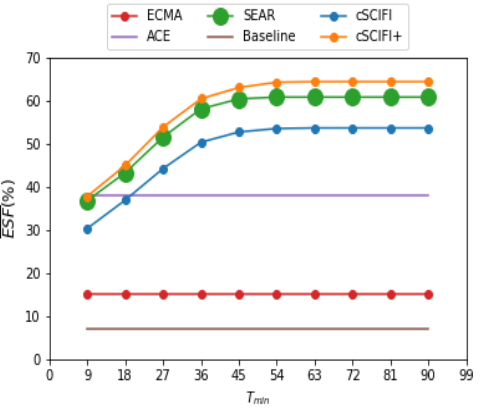
Figure 5. Normalized Energy saving factor for different T min